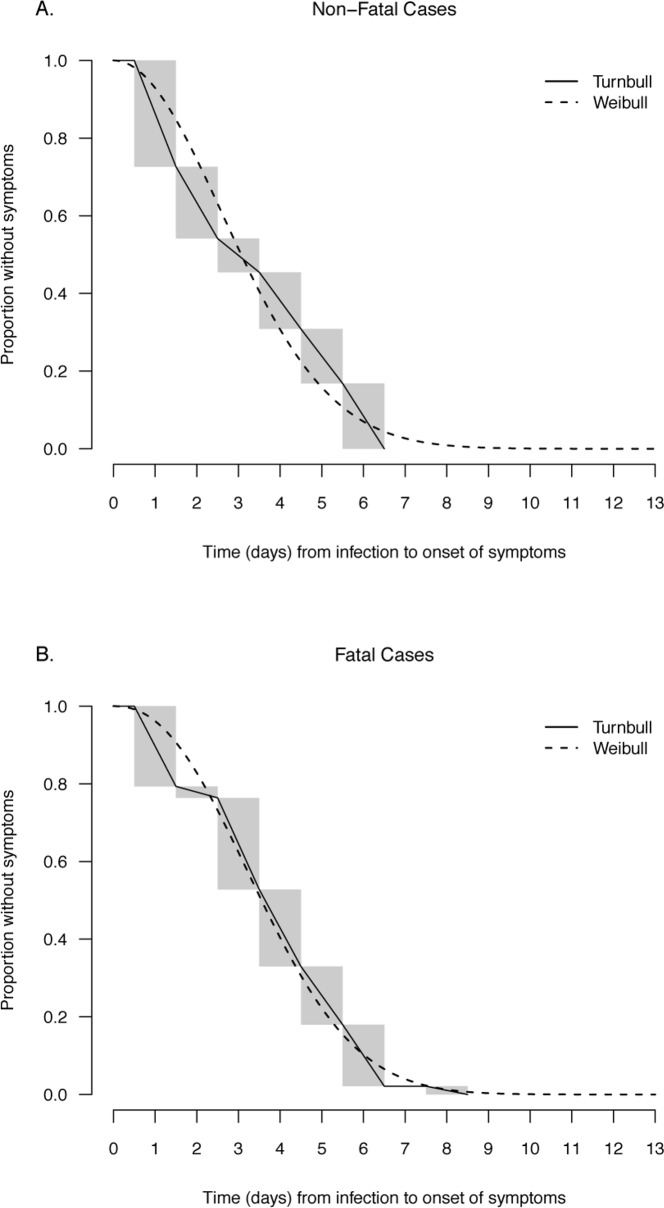
Parametric (Weibull) and nonparametric estimates (Turnbull) of the distribution of incubation periods for human avian influenza A(H7N9) virus infections for fatal cases (above) and non-fatal cases (below).